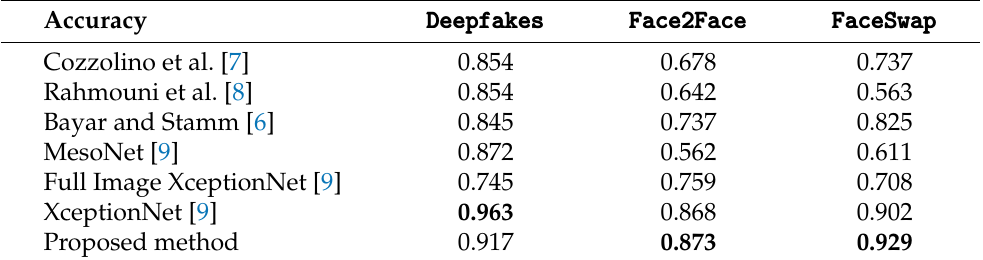
Table 9. Comparison of the results for detecting Face2Face , FaceSwap , Deepfakes manipulation methods trained on low-quality images. These values, other than the proposed method, are obtained from Table 2 of the reference